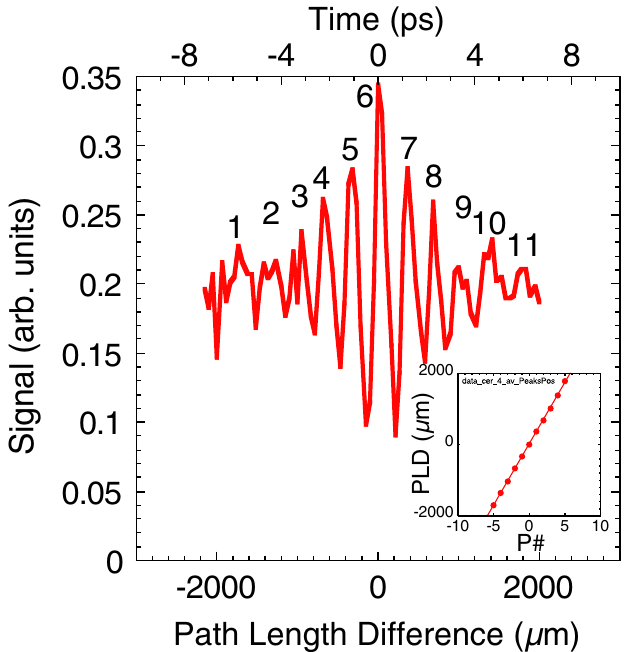
FIG. 9. (Color) CTR interferometer trace for the mask with d ¼ 500 (cid:8) m and D ¼ 1 : 27 mm corresponding to the case of Fig. 6. The distance between the peaks is determined from a linear fit of the measured path length difference (abbreviated PLD) versus peak number (abbreviated P # ) shown in the inset for the 11 peaks (six bunches). The slope of the curve and therefore the distance between the bunches is about 344 (cid:8) m